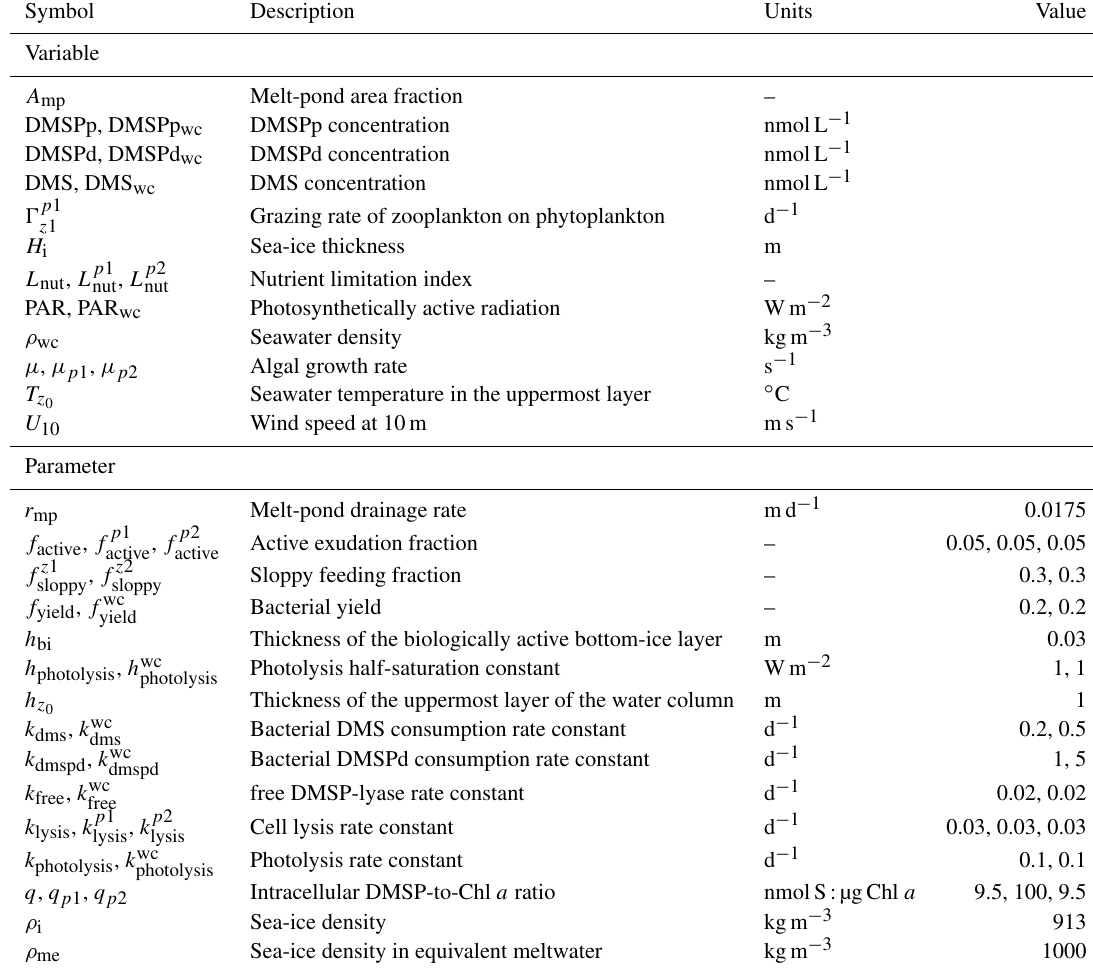
Table 1. List of the coupled sea ice–ocean sulfur cycle model variables and parameters. Symbol Description